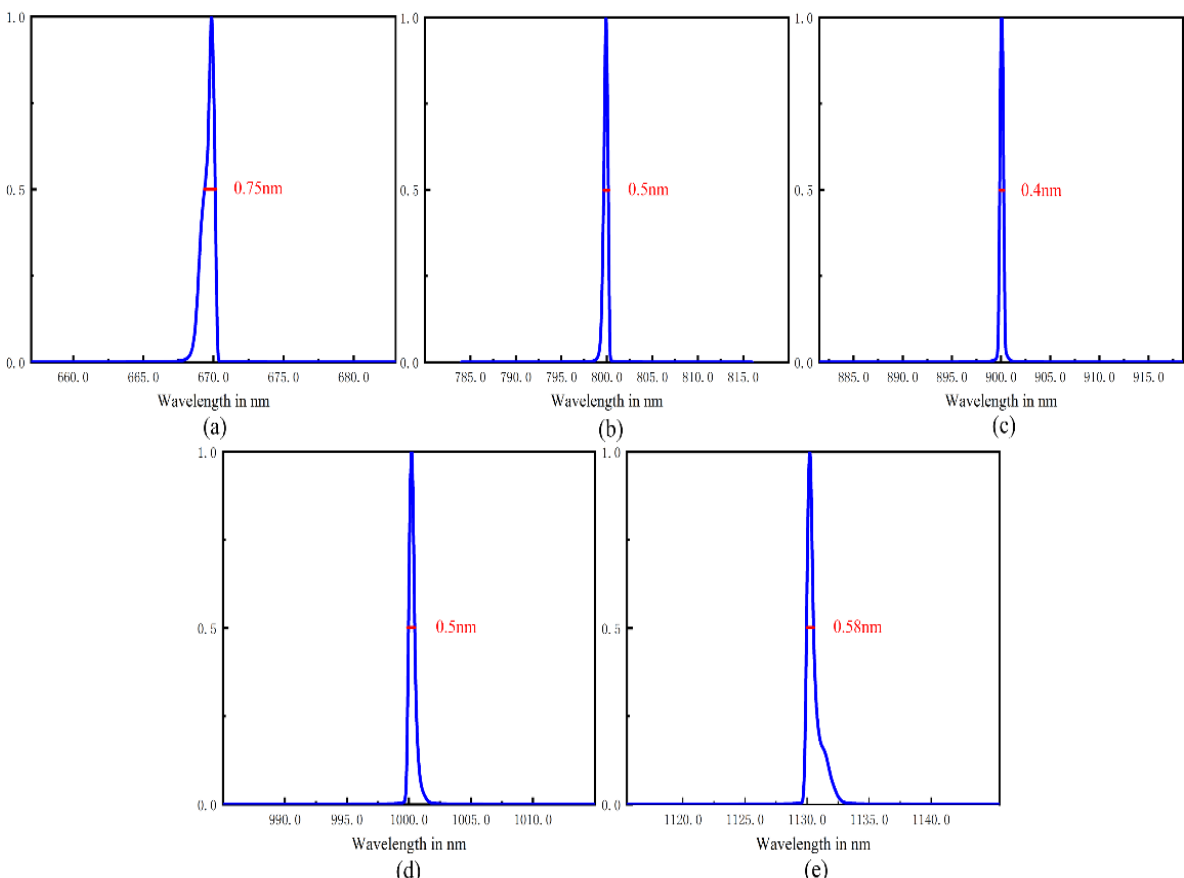
Figure 6. The spectral resolution of the UTCT at typical wavelengths.